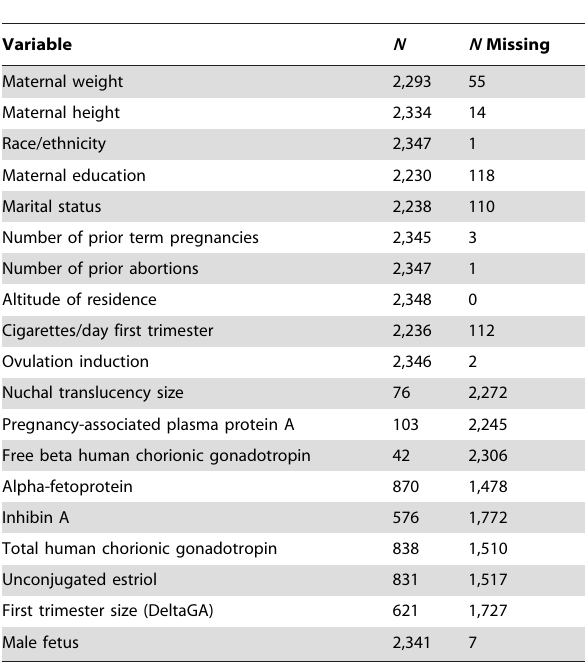
Table 2. Variables used to compute individualized expected birth weight at 280 d for SCRN singleton stillbirths and live births (unweighted n =